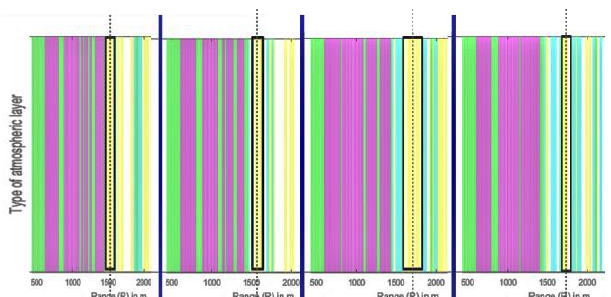
Fig. 4. WIND METCON algorithm [3] presentation of four sequential lidar data recording files every 10”. The tracking of a certain atmospheric layer in Yellow color (“Light Haze” depicted with dashed line in its center) begins at ∿ 1500m height and travelling up to 1750m in 30”, presenting a layer tracking (wind) speed of 8.3m/s at that time and then it was lost as a specific layer. Air masses movement through atmospheric layer detection and the replacement of the “free” space in be tween by other atmospheric layer, is depicting the air masses movement and changes around PBLH and other atmospheric mixtures with time. The blue vertical lines represent distinguishes consecutive lidar